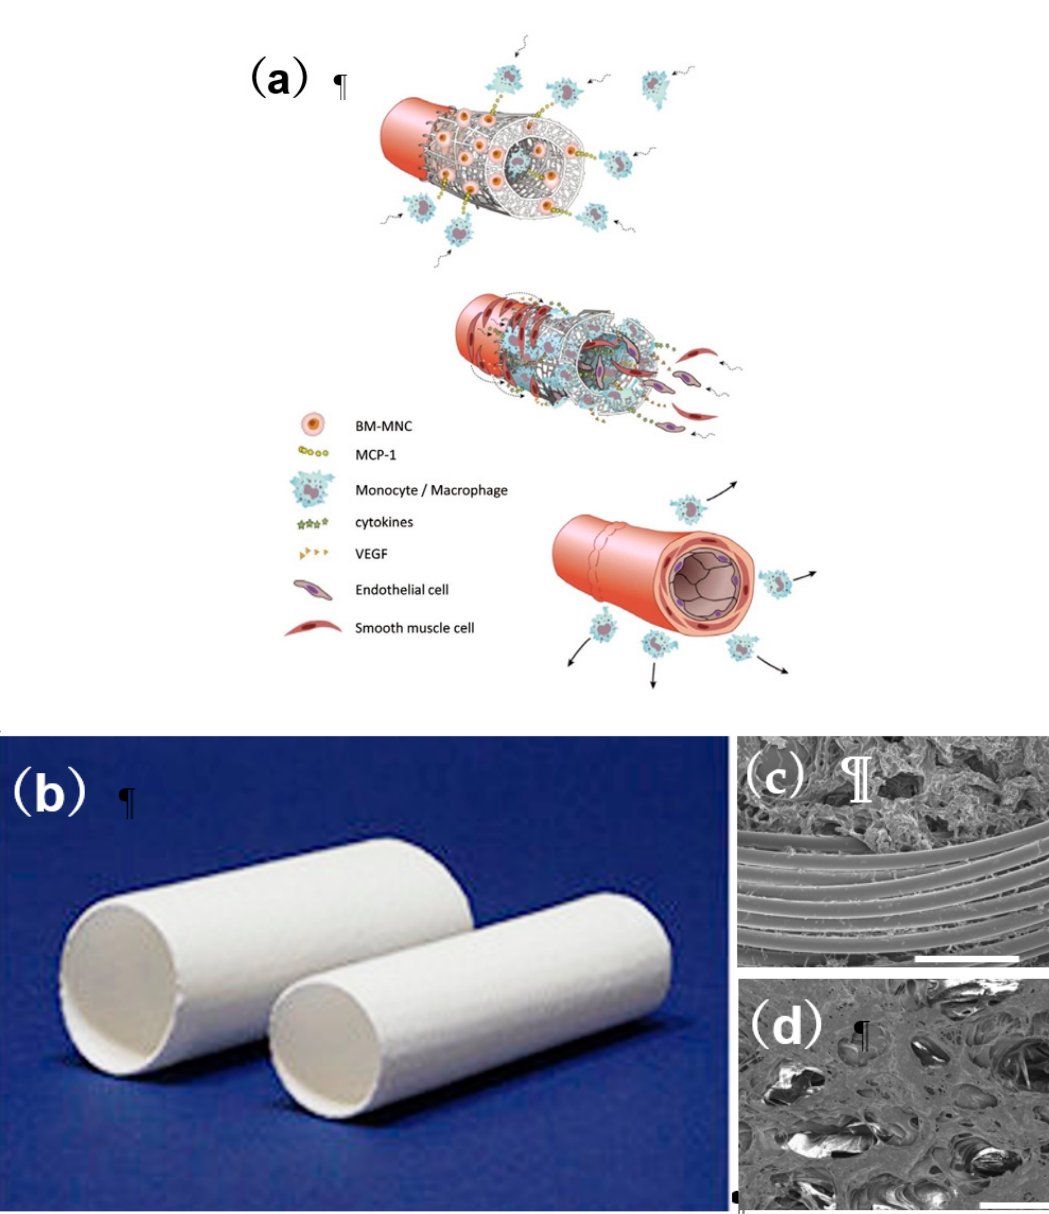
Figure 2. ( a ) Proposed mechanism of neovessel formation after implantation of a cell-seeded biodegradable scaffold. Early pulse of monocyte chemoattractant protein-1 (MCP-1) and related cytokines from seeded bone marrow-derived mononuclear cells (BM-MNCs) enhances early monocyte recruitment to the scaffold. Infiltrating monocytes release multiple angiogenic cytokines and growth factors (e.g., vascular endothelial growth factor (VEGF)), which recruit smooth muscle cells. ( b ) Appearance of tissue engineered vascular graft (TEVG). TEVG has a thickness of 1 mm, and mainly has a length of 13 cm; they are trimmed and implanted according to the anatomy of the patient. ( c ) SEM image of Woven poly (glycolic acid) (PGA). ( d ) SEM image of luminal PCLA; the bar shows 100 µ m adopted with permission from Shinoka et al.